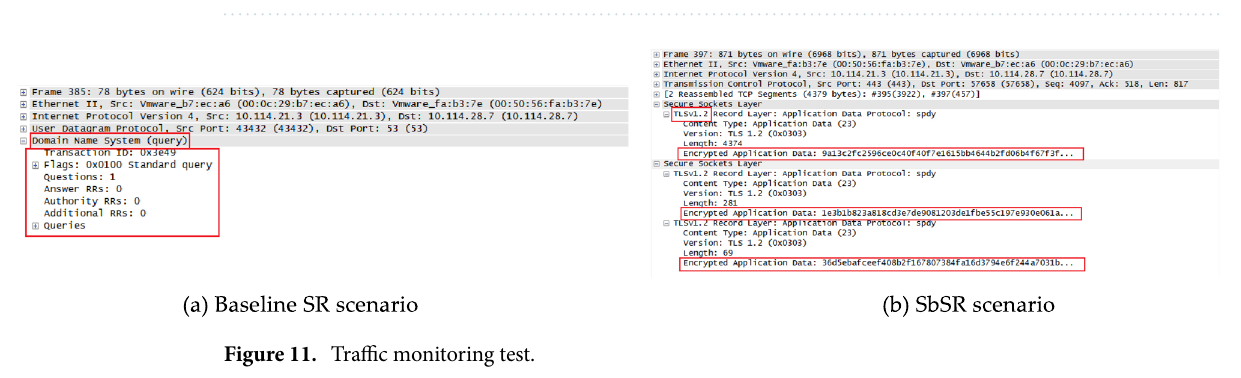
Figure 11. Traffic monitoring